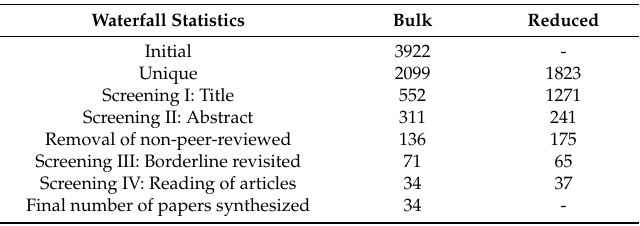
Waterfall statistics showing how many articles were excluded in each step of the screening